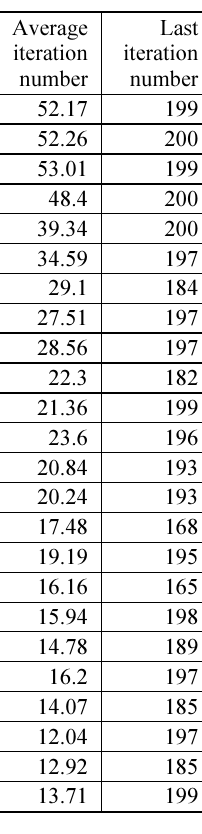
Table 5. Dependency of the convergence rate on the